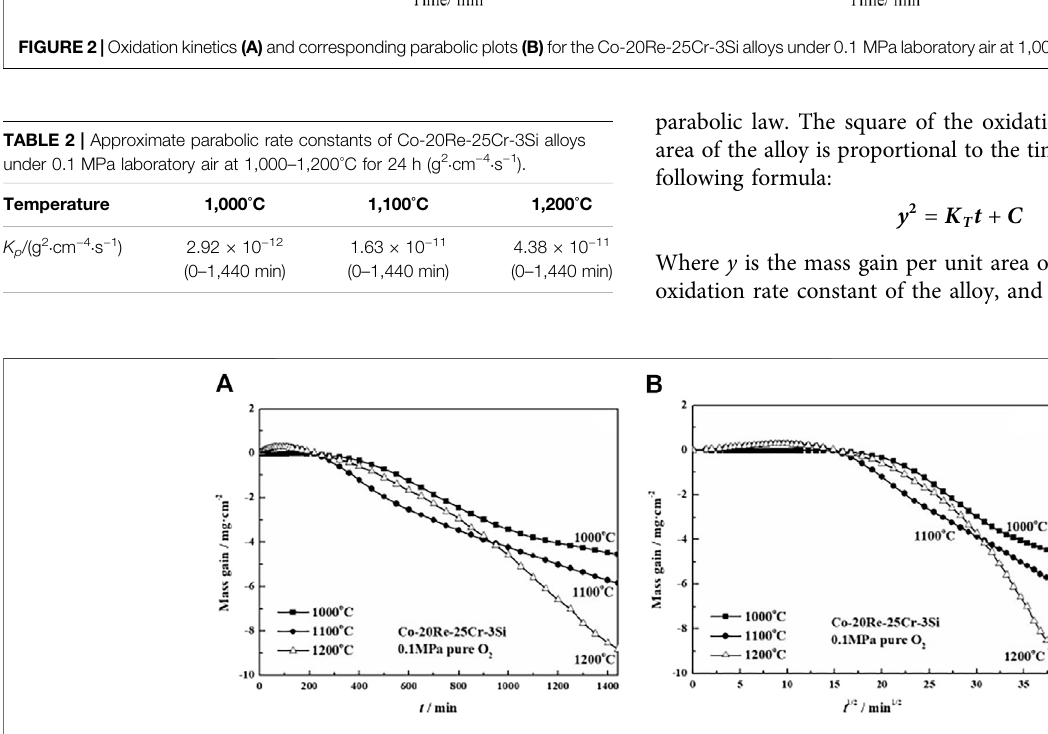
FIGURE 3 | Oxidation kinetics (A) and corresponding parabolic plots (B) for the Co-20Re-25Cr-3Si alloys under 0.1 MPa pure O 2 at 1,000 – 1,200 ° C for 24 h (Wang, 2019).